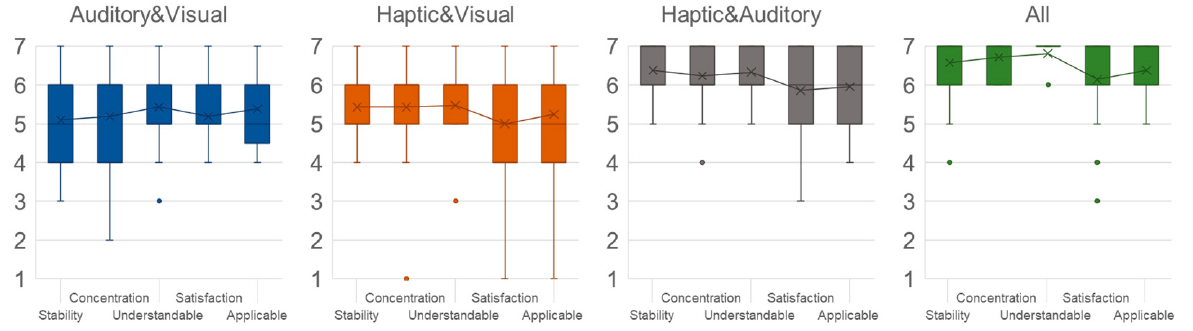
Figure 14. Survey evaluations for multimodality TOR ( 𝑛 = 39 ).